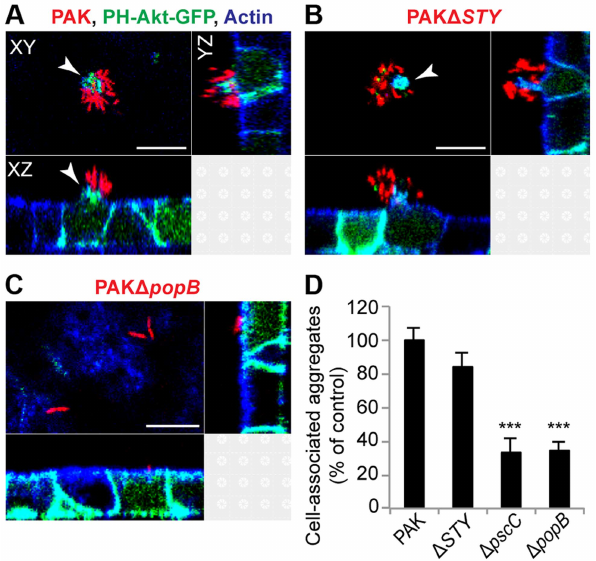
Figure 2. Cell-associated aggregation requires the T3SS translocon but does not require T3SS effectors. MDCK cells stably transfected with PH-Akt-GFP (green) were infected with mCherry- expressing (A) PAK, (B) PAK D STY (lacks the known T3SS effectors), or (C) PAK D popB (has the functional needle apparatus but lacks the translocon) for 60 minutes, fixed, and stained for actin (blue). Cell- associated aggregates (red) were visible with PAK (A) and PAK D STY (B) and were accompanied by formation of membranous protrusions (white arrows) containing PH-Akt-GFP. PAK D popB (C) bound individu- ally or as groups of 2 to 3 bacteria. Representative confocal images from three independent experiments are shown. Scale bars, 10 m m. (D) Cell- associated aggregation by PAK and T3SS mutants was quantified using spinning disk confocal microscopy. Shown is the number of aggregates ( $ 10 bacteria) normalized to PAK (n $ 3 independent experiments). Data are mean 6 SEM. ***p , 0.001 compared to PAK. Statistics in Supplemental Statistical Analysis (Text